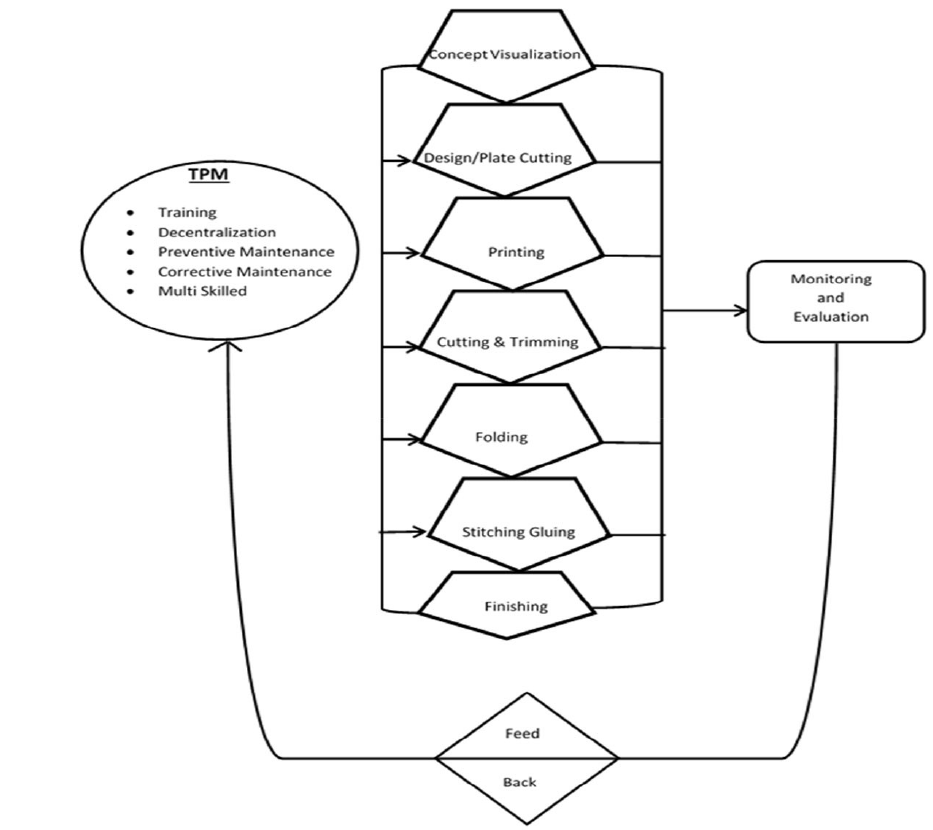
Figure 9. Strategic Framework for Total Productive Maintenance for AB production